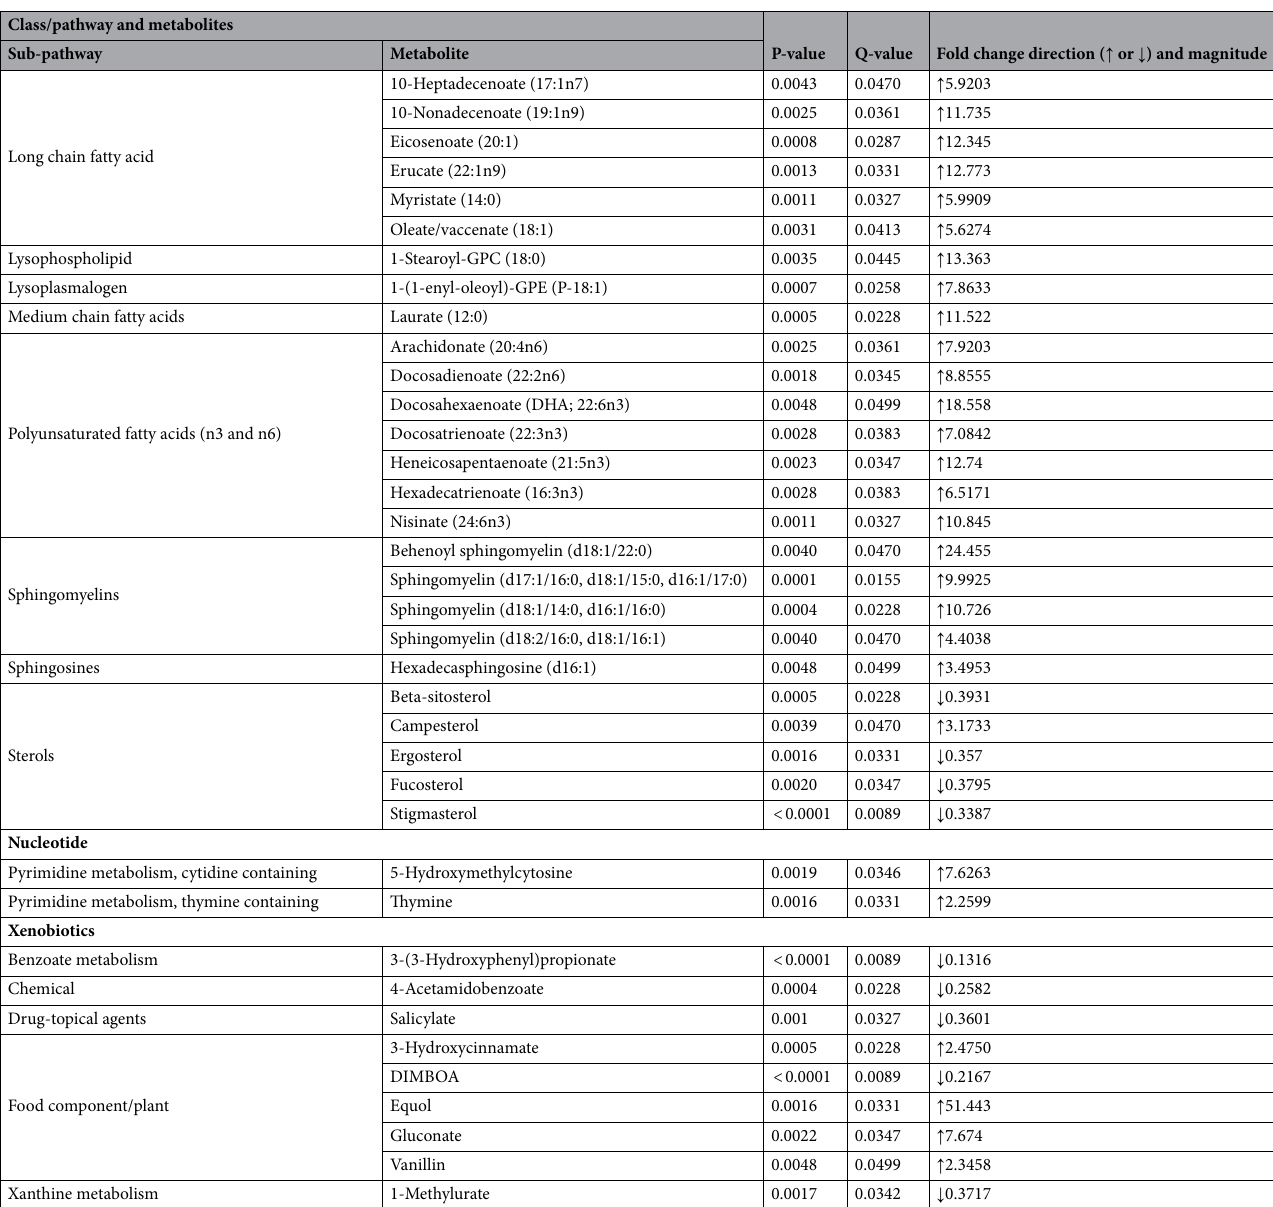
Table 2. Metabolites and pathways significantly altered in cats with chronic enteropathy (CE). ↓ indicated downregulation and ↑ indicates upregulation compared with findings in healthy control cats. Fold change was calculated for cats with CE relative to healthy